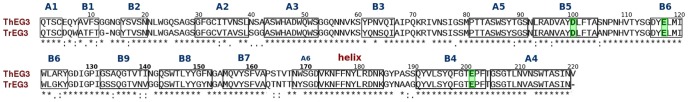
Comparison of the primary structure of the ThEG3 and TrEG3.Alignment of the primary sequence of ThEG3 and TrEG3 with the catalytic triad residues marked in green. The symbols are the adopted by the ClustalW tool (http://www.clustal.org/clustal2/), in which the asterisk indicates fully conservation of the residue, the colon indicates residues with strongly similar properties, and period, residues of weakly similar properties.